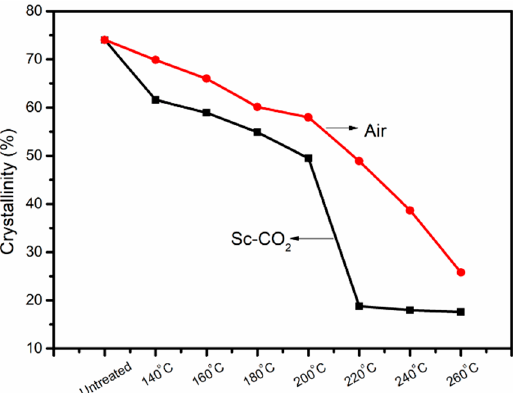
Figure 5. The crystallinities of PAN fibers treated in the air and Sc-CO 2 .